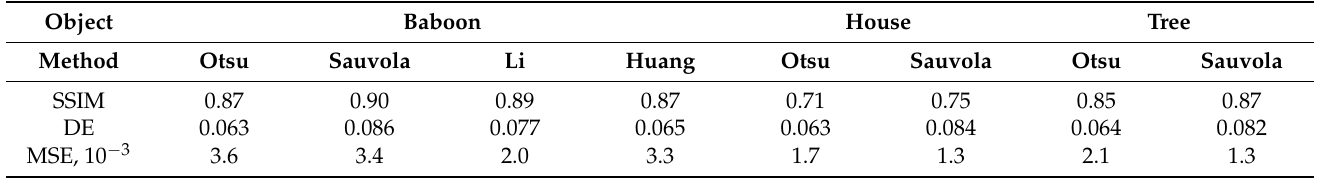
Table 2. Quality and diffraction efficiency of the numerically reconstructed binary holograms.